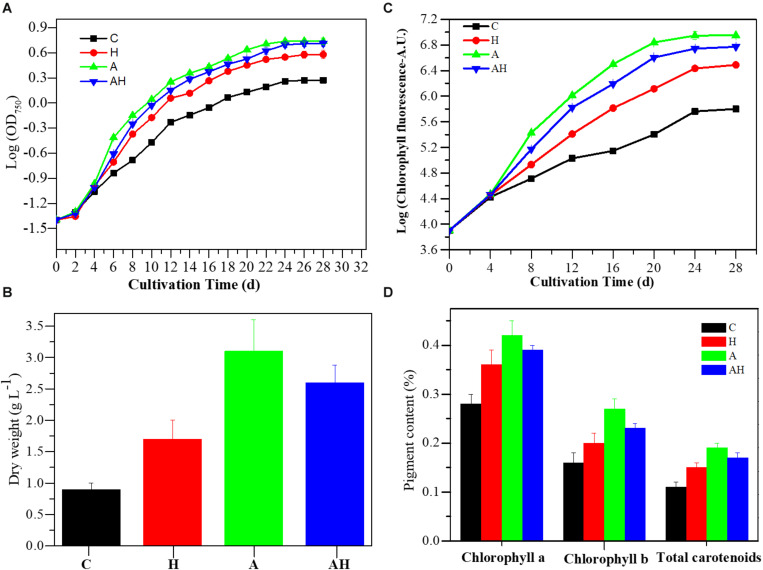
Growth characteristics of Symbiochlorum hainanensis in response to acidification and warming conditions. Growth curves (A), cellular dry weight [(B) day 20], chlorophyll fluorescence (C), and pigment content [(D) day 20] of S. hainanensis under the control (in situ temperature)—C (n = 3), elevated temperature—H (n = 3), acidification—A (n = 3), and combined treatment—AH (n = 3). All results are presented in the text as mean ± standard error.